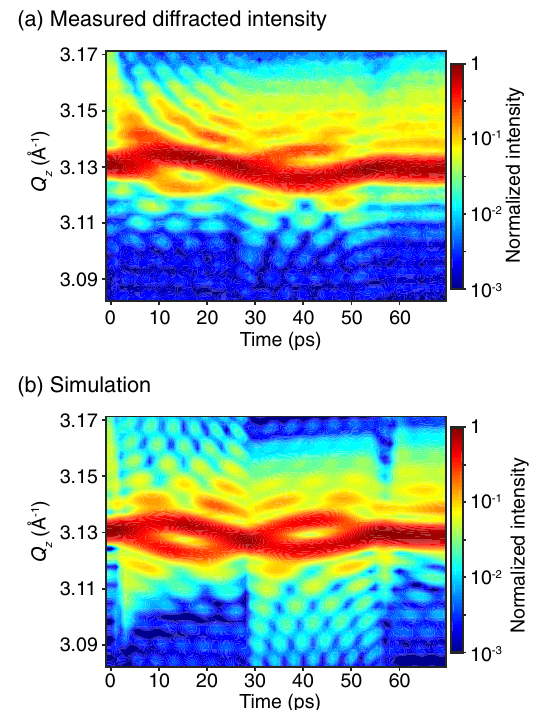
FIG. 2. Photoinduced lattice distortion of the PTO/STO SL. (a) Measured and (b) simulated time dependence of the distri- bution of intensity as a function of Q z near the SL 002 Bragg reflection. Intensity is normalized to the peak intensity of the 002 Bragg reflection at t < 0